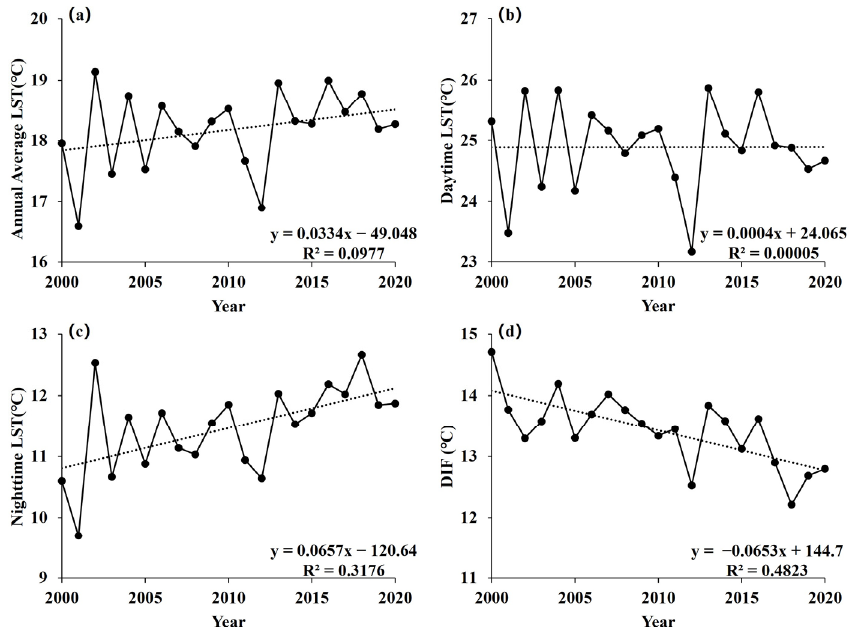
Figure 3. Interannual trends of LST in the Qinling-Daba Mountains from 2000 to 2020: ( a ) annual average LST; ( b ) daytime LST; ( c ) nighttime LST; and ( d ) DIF.